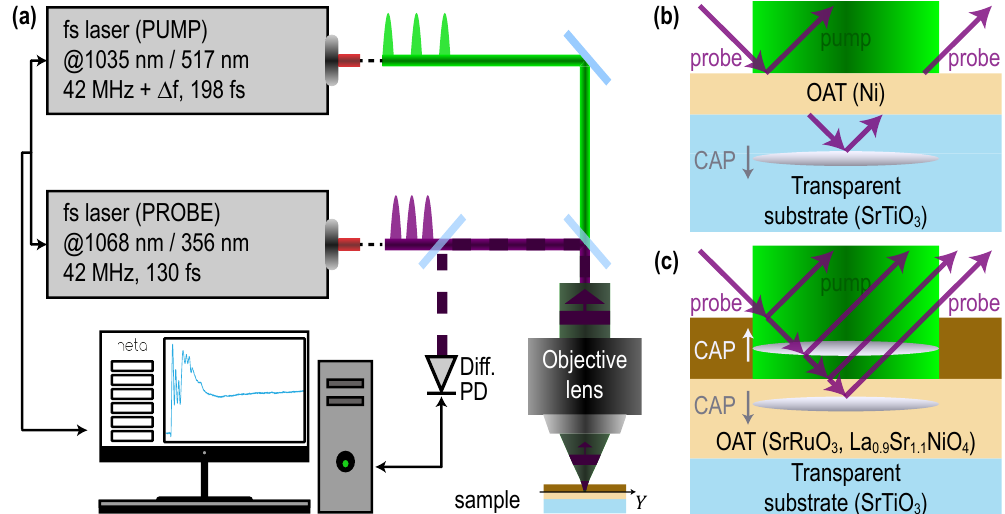
Figure 2. ( a ) Schematic presentation of a picosecond acoustic microscope based on asynchronous optical sampling. ( b , c ) Schemes of the optical rays and of the coherent acoustic pulses (CAPs) propagation in typical multilayered samples. OAT denotes pump light absorbing optoacoustic transducer, which launches CAPs due to an optoacoustic conversion initiated by the absorption of pump laser radiation. The top brown layer in ( c ) denotes the transparent epitaxial films of either the laterally homogeneous Ba 0.6 Sr 0.4 TiO 3 material or the laterally graded Ba 1 − x Sr x TiO 3 library material. Note that in parts ( b , c ), the probe beams are shown as oblique for a clearer representation of the reflections, while the probe beam was actually normal to the surface of the